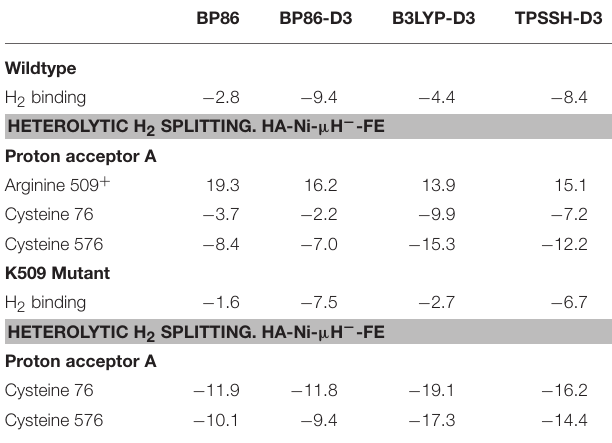
TABLE 6 | Substrate binding energies and thermodynamics of heterolytic H 2 splitting (in kcal/mol) in the wildtype and R509K mutant [NiFe]-hydrogenase from E. coli